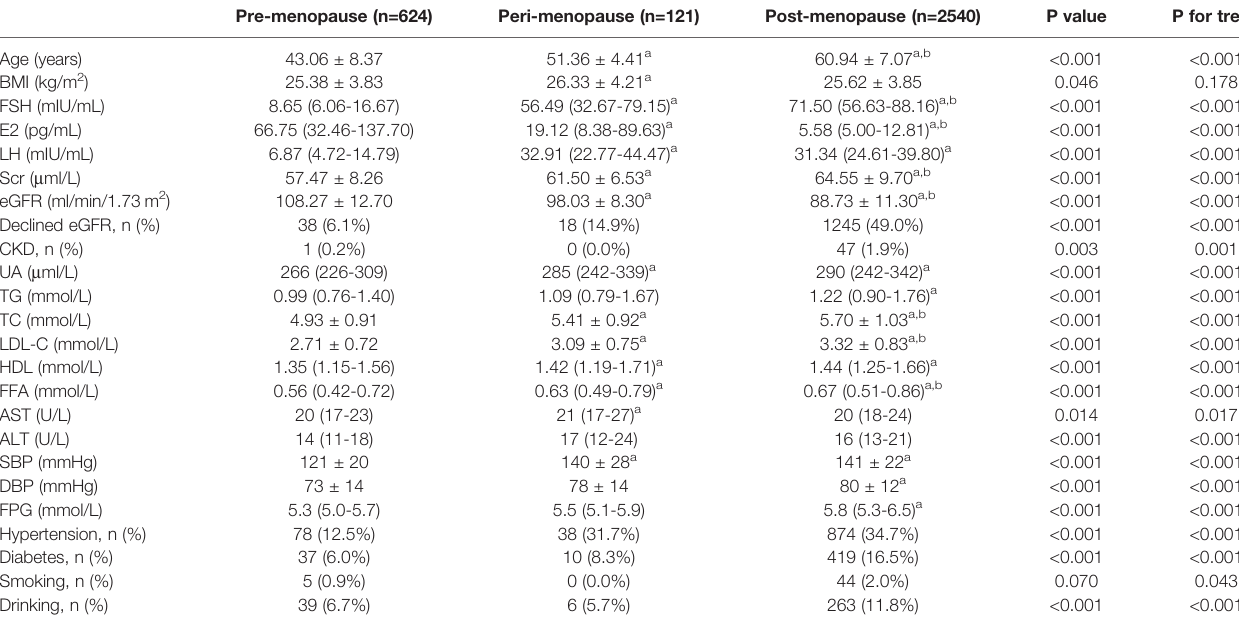
TABLE 1 | Clinical characteristics of the three groups according to menopausal